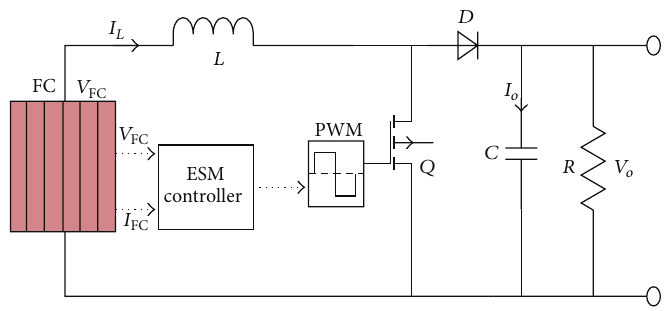
Figure 3: Schematic diagram of proposed FC